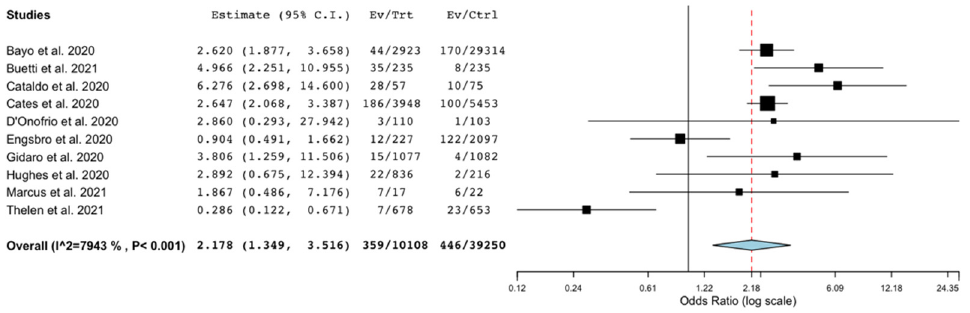
Figure 4. Occurrence of bloodstream infection in patients with COVID-19 compared with patients without COVID-19. Forest plot with the results of the sensitivity analysis on the occurrence of BSI in patients with COVID-19 compared to patients without COVID-19. BSI, bloodstream infection; CI, confidence interval; Ctrl, controls; Ev, events; Trt, total.